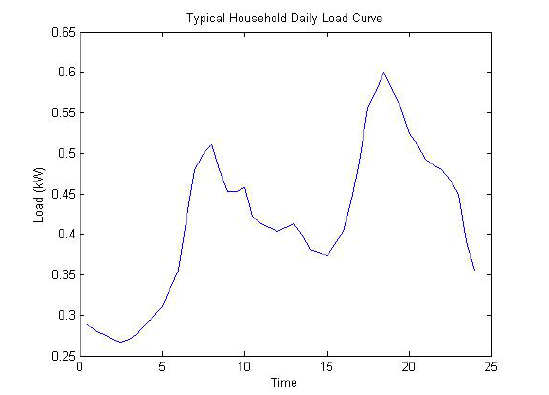
Figure 2: Typical Household Daily Load curve.